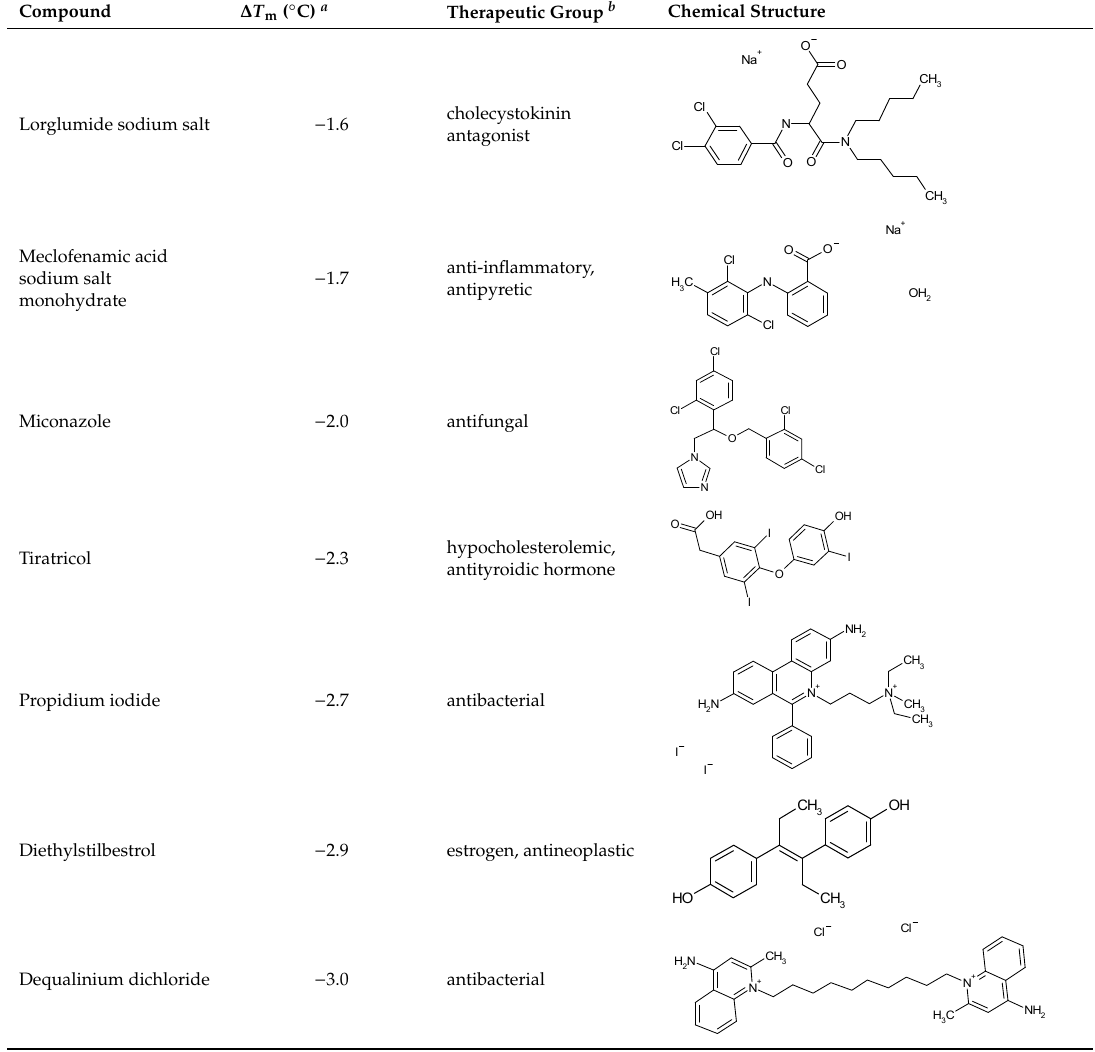
Table 1. ArsR binders identified by HTS of the Prestwick Chemical Library ® using a fluorescence-based thermal shift assay.